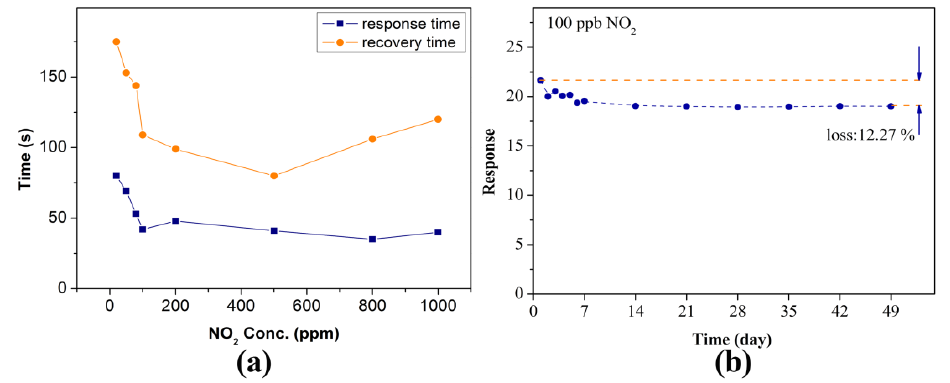
Figure 5. ( a ) Response and recovery time of WN/WO 3 composites sensor to various concentrations of NO 2 at RT. ( b ) Stability measurement of the WN/WO 3 composites sensor to 100 ppb NO 2 at RT for 7 weeks.